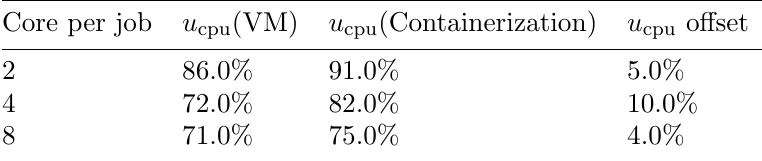
Table 2. ATLAS job CPU efficiency: VM vs.